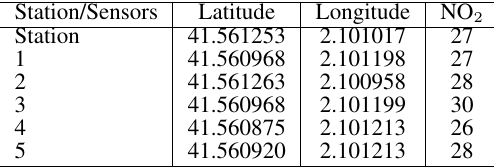
Table 1. Dates of acquisition campaigns. Station/Sensors